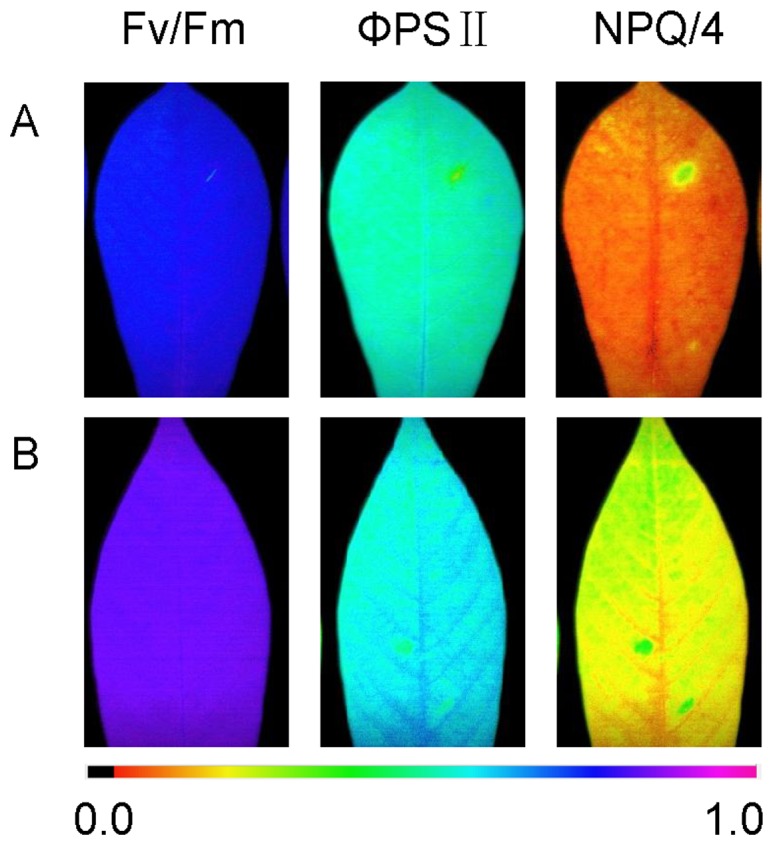
Imaging pulse amplitude modulation of cassava leaves from NZ199 diploid and autotetraploid genotypes.A, diploid genotype; B, autotetraploid genotype; Parameters shown are Fv/Fm [maximal photosystem II (PSII) quantum yield], ΦPSII (effective PSII quantum yield) (at 185 µE m−2 s−1), and NPQ/4 (nonphotochemical quenching) (at 185 µE m−2 s−1). The color gradient provides a scale from 0 to 100% for assessing the magnitude of the parameters.